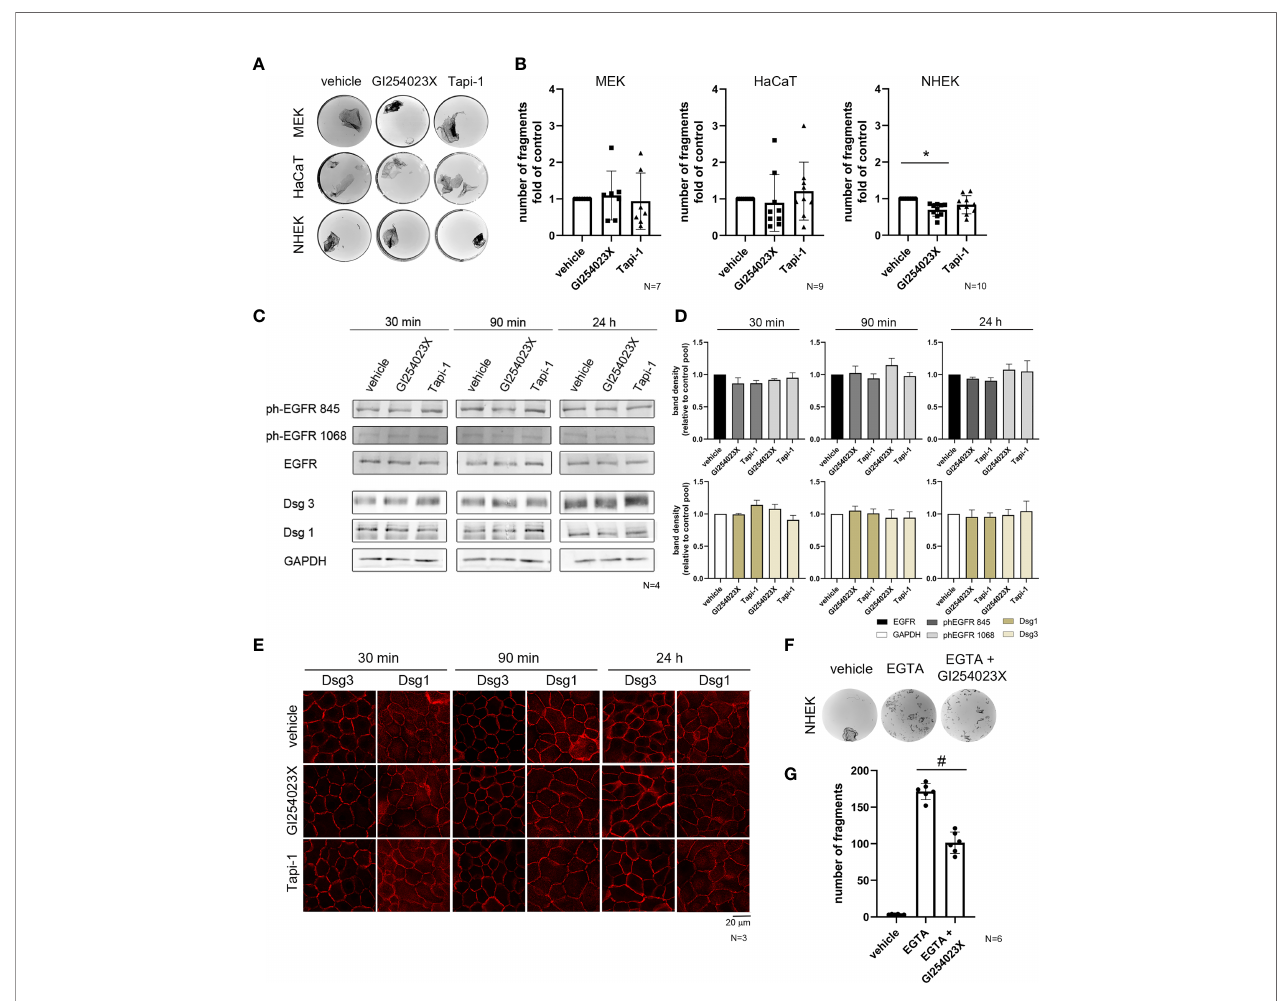
FIGURE 1 | ADAM10 inhibition improved cell adhesion in primary keratinocytes and induces hyperadhesion. (A) Dispase-based keratinocyte dissociation assays were performed by applying shear stress on epidermal monolayers. Images show the fragmentation of cell monolayers for three different epithelial keratinocyte cell types with or without inhibition of ADAM10 (GI254023X) and ADAM17 (Tapi-1) for 24 h. (B) Quanti fi cation of the dissociation assay for MEK cells and HaCaT cells showed no signi fi cant difference between control conditions (vehicle), and the incubation with ADAM10-inhibitor ( p > 0.99), whereas in NHEK cells, inhibition of ADAM10 by GI254023X reduced cell sheet fragmentation signi fi cantly (* p = 0.001). In contrast, there was no effect of inhibition of ADAM17 in all cell types ( p > 0.99) (n ≥ 7). Western blot analysis (C) and its quanti fi cation (D) showed no signi fi cant difference in total protein amount of Dsg1 and Dsg3. GAPDH was used as a loading control. There was no signi fi cant activation of EGFR at Tyr845 and Tyr1068 in comparison to the total amount of EGFR (n = 4). (E) Immunostaining for the desmosomal proteins Dsg1 and Dsg3 showed no remarkable difference, due to the inhibition of ADAM10 (GI254023X) and ADAM17 (Tapi-1) compared to the respective control condition (vehicle). (F) Hyperadhesion dissociation assays in NHEK were performed. Inhibition of ADAM10 enhanced cell adhesion after incubation with the Ca 2+ chelator EGTA. (G) Quanti fi cation of hyperadhesion dissociation assay showed a signi fi cant reduction of cell sheet fragments after inhibition of ADAM10 ( # p < 0.0001; n =